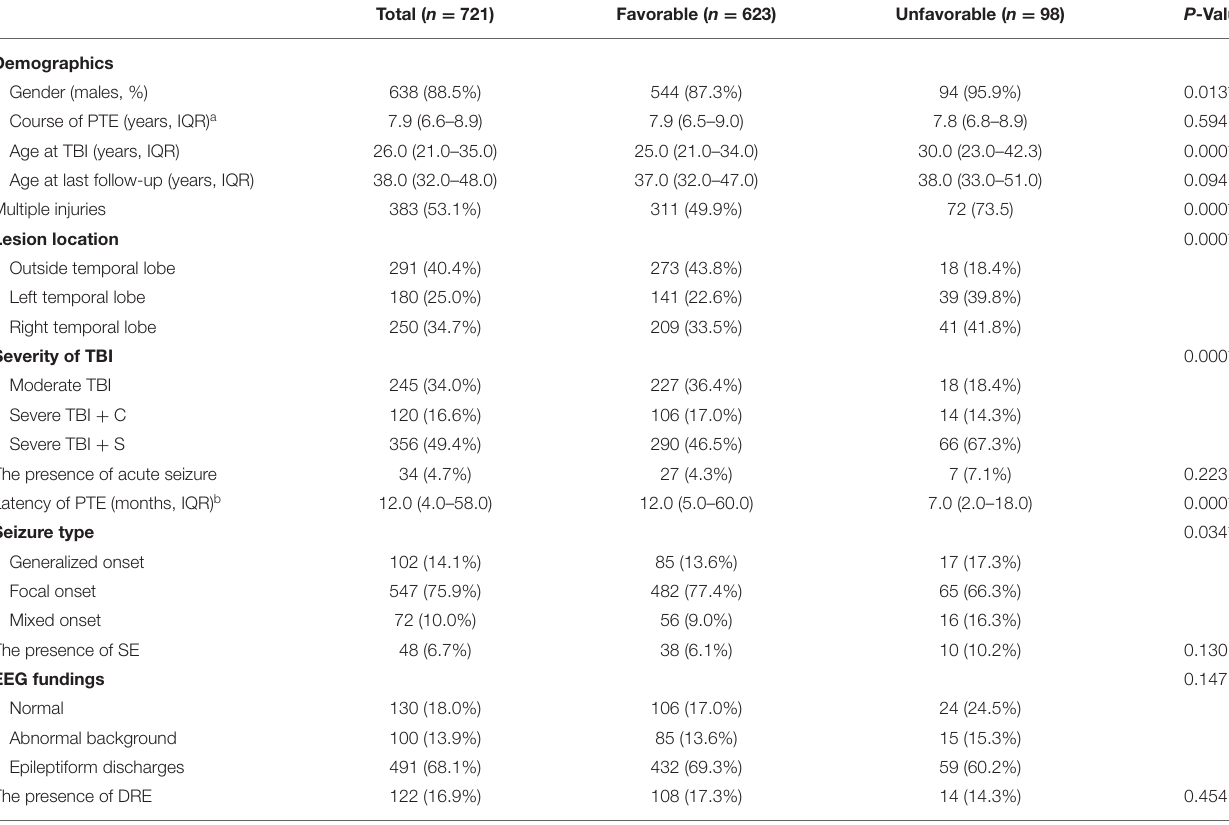
TABLE 1 | The favorable outcome group vs. the unfavorable outcome group comparison summary